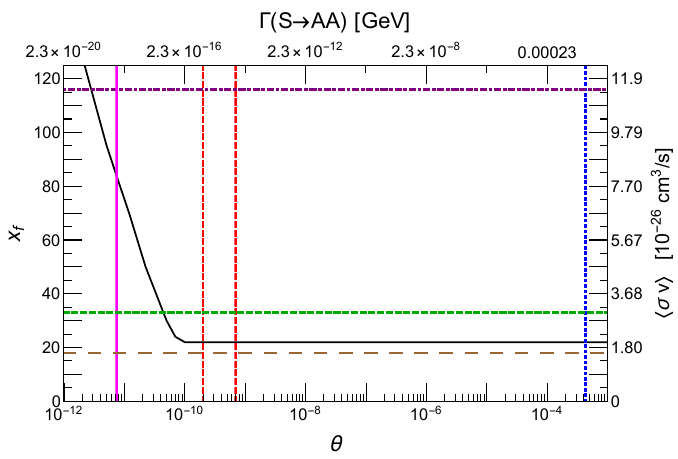
Figure 9 . x f (or the XX ! SS annihilation cross section h (cid:27)v i ) as a function of (cid:18) (or (cid:0)( S ! AA )), denoted as the black curve to show the relic result, where we have adopted (cid:14) = 0 and the parameters given in eq. (5.1). When the (cid:18) is smaller than that denoted by the vertical dotted (blue) line, the GC gamma-ray excess is dominated by the 2-step cascade annihilation. For a (cid:18) smaller than that denoted by right dashed (red) line, the dark sector decouples from the thermal bath when x . 1. The range of (cid:18) between the two vertical dashed (red) lines denotes that the DM X as well as the mediator S can be again in thermal equilibrium with the thermal bath before freeze out. The horizontal dot-dashed (purple) line shows the maximum value of the annihilation cross section that could still account for the GC gamma-ray excess. The 95% C.L. upper limit and project sensitivity for observation of dSphs are denoted as horizontal dashed (green) and long-dashed (brown) lines, respectively. For a (cid:18) smaller than that denoted by the vertical solid (magenta) line, we have x (cid:0) > x f